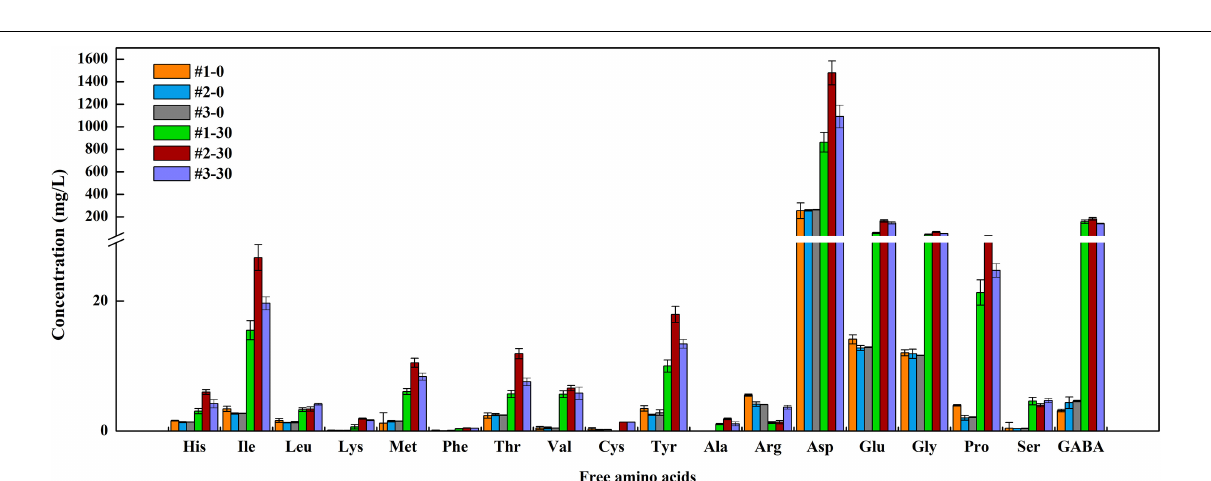
Frontiers in Microbiology |